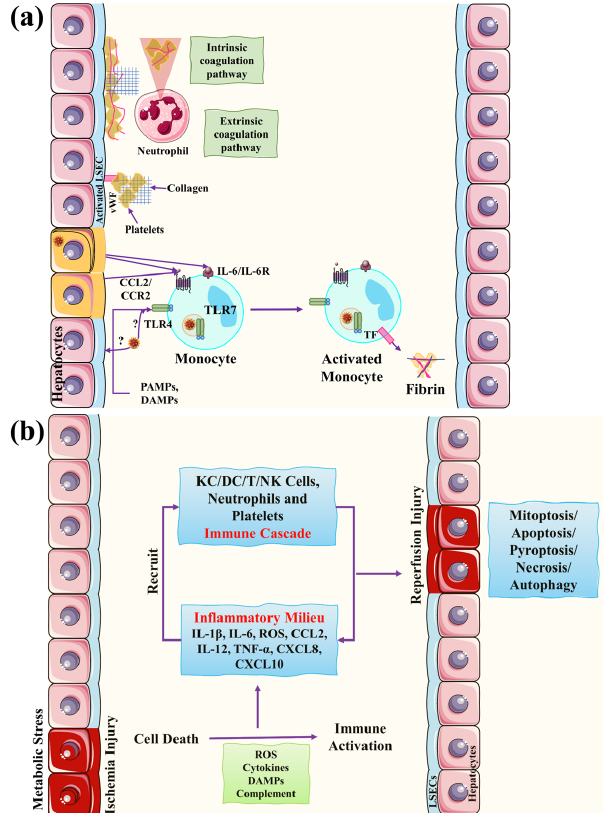
Figure 4. COVID ‐ 19 ‐ associated liver damage mechanisms of impaired coagulation and hepatic is ‐ Figure 4. COVID-19-associated liver damage mechanisms of impaired coagulation and chemia/hypoxia reperfusion injury. ( a ) In those with severe COVID ‐ 19 and hepatic impairment, co ‐ agulation problems have been associated with negative results. Monocytes are drawn to endothelial